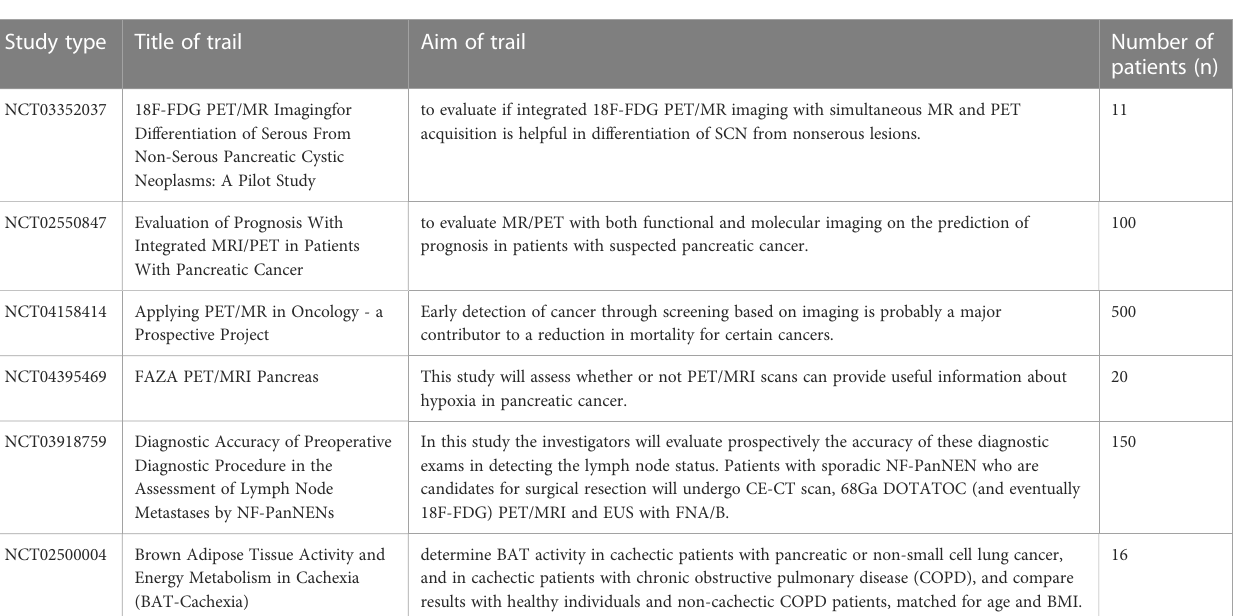
TABLE 2 Clinical trial of pancreatic lesions based on